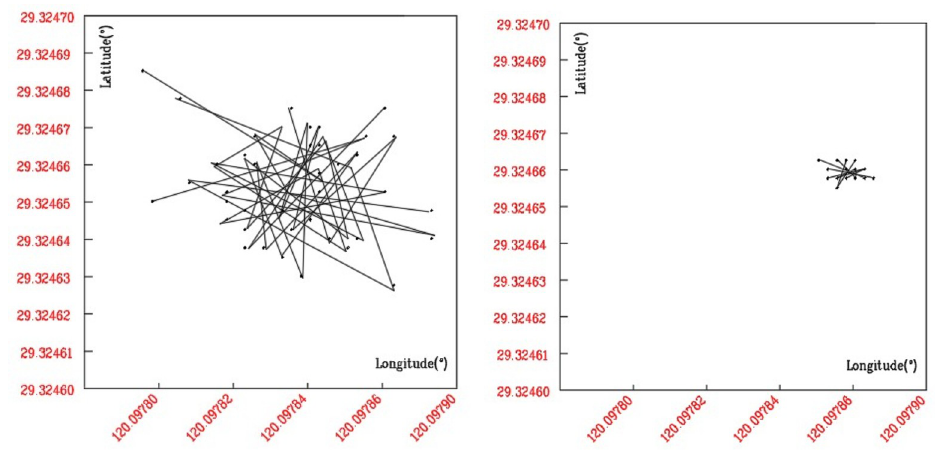
Fig 1. GPS data distribution before and after SAGE-HUSA adaptive